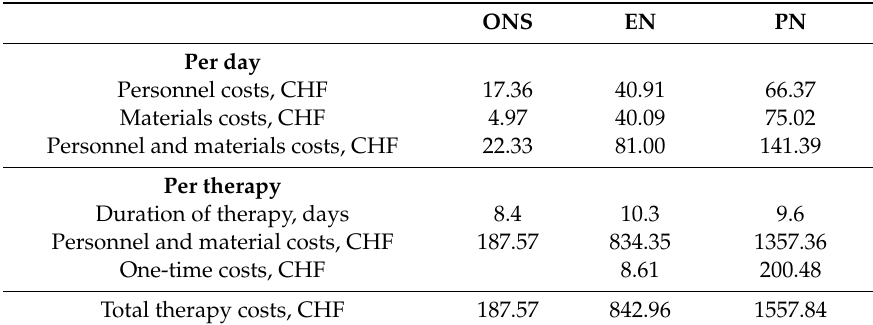
Table 2. Costs of nutritional interventions (NI) per patient and